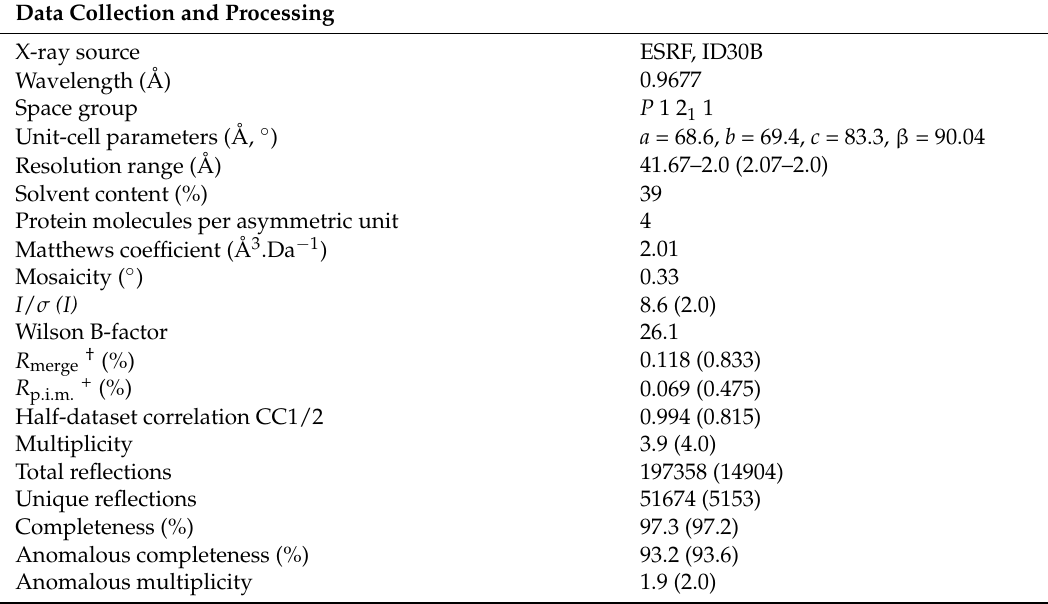
Table 1. X-ray diffraction, model building, and refinement statistics (values for the outer shell are given in